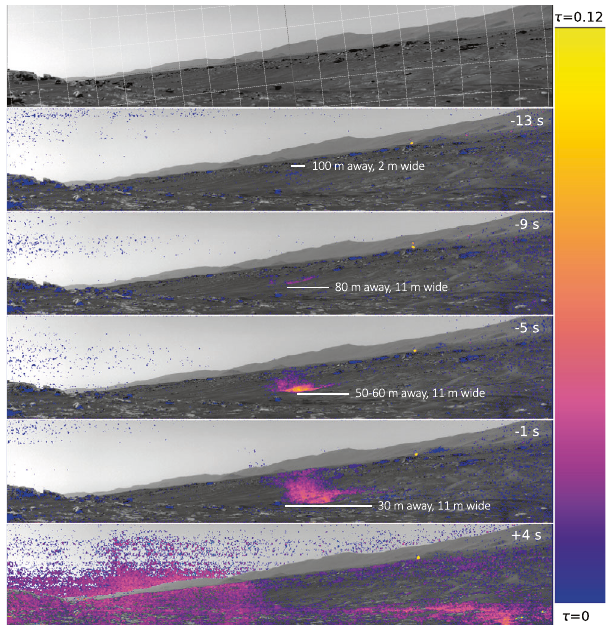
Fig.3|Therover ’ sNavigationCamera(Navcam)observationsofthedirectdust devil encounter. The Navcam scene (the average background image, top panel) and each dust devil image processed to dust amount ( fi ve lower panels), masking out only the truly indeterminate areas (grey). The colour scale ranges from optical depth, τ =0 at the bottom (blue) to τ =0.12 at the top (yellow), and is linear in between. The areas with low signal-to-noise ratio are masked out, and the images also show non-random noise (banding from instrument electronics during read- out). The grid on the scene image (top panel) is 5° in local level azimuth and elevation; the darker grey contours are Elevation=0° and Azimuth=165°. The fi rst dust devil image was taken at the rover spacecraft clock (SCLK) time of 686020326s. The time indicated in the top right corners of the images is with respect to the start of the SuperCam microphone